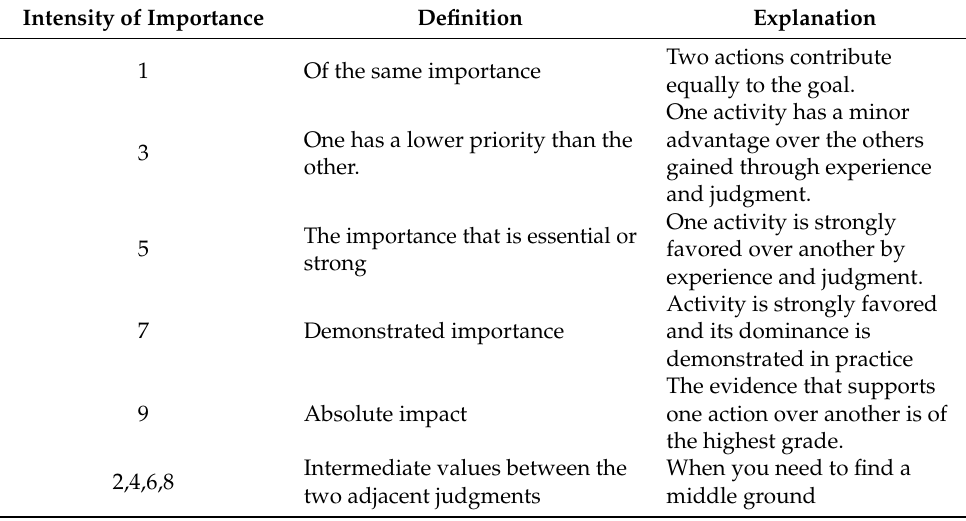
Table 2. Nine scales of pairwise